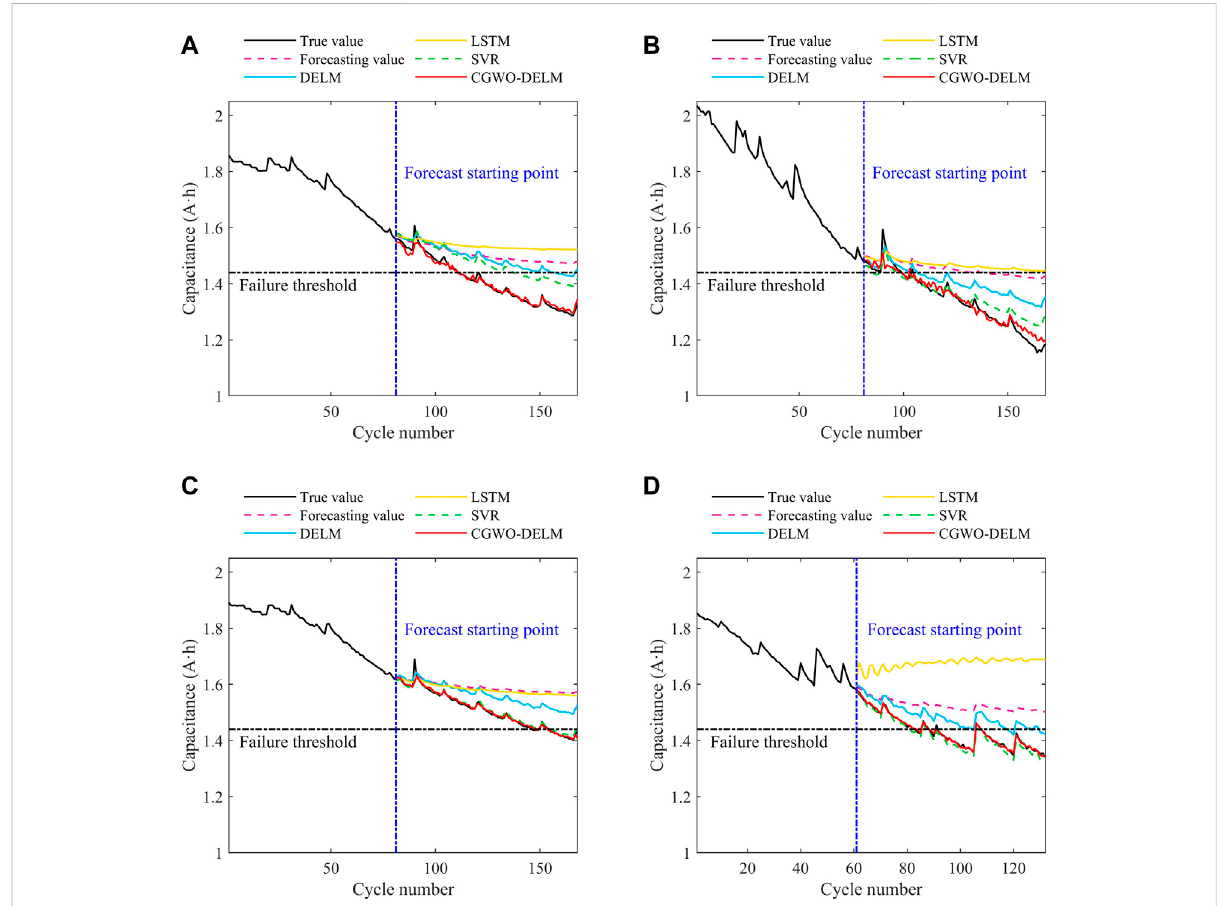
FIGURE 9 RUL prediction results of lithium-ion battery by CGWO-DELM and four other prediction methods (the fi rst 80 cycles of data are used as the training set). (A) Battery B0005. (B) Battery B0006. (C) Battery B0007. (D) Battery